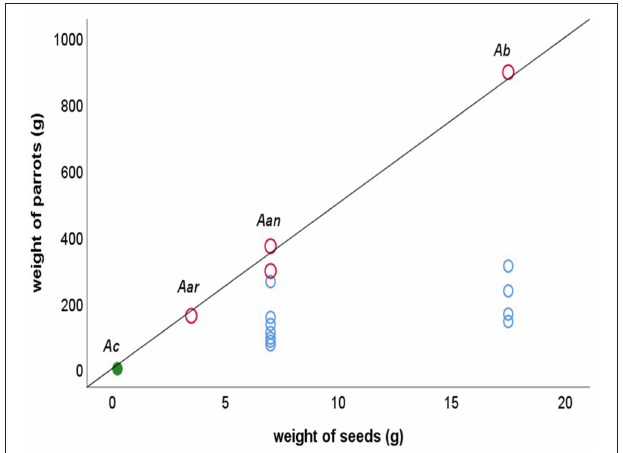
FIGURE 3 | Relationship between the seed weight of three Araucaria species ( Aar, A. araucaria; Aan, A. angustifolia; Ab, A. bidwillii ) and the body mass of parrot species that disperse them (red circles). Blue circles represent parrot species that have a small (for Aan ) or null seed dispersal role (for Ab ). The diagonal line represents the expected perfect correlation between seed size and parrot size. A. cunninghamii ( Ac ) is depicted (green dot) as a reference, since no parrots disperse its seeds (they are only dispersed by barochory and